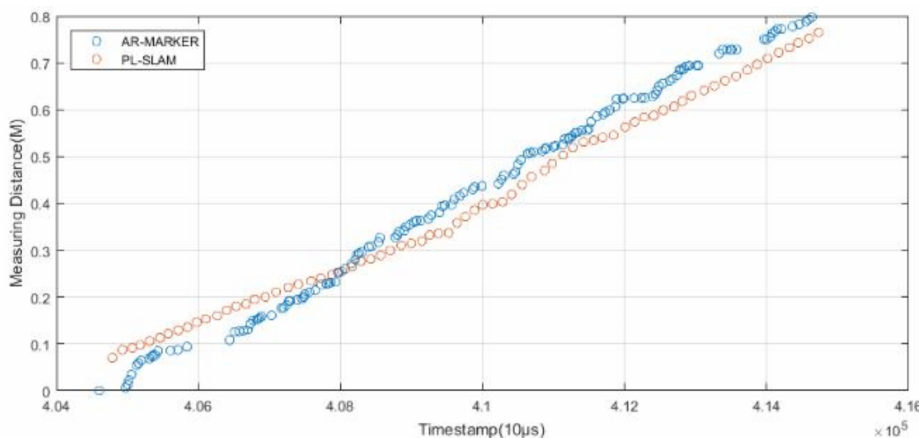
Figure 9. Result of the linear motion experiments in the X-direction, using the AR-marker recognition program and PL-SLAM simultaneously. The experimental diagram is shown in Figure 7.